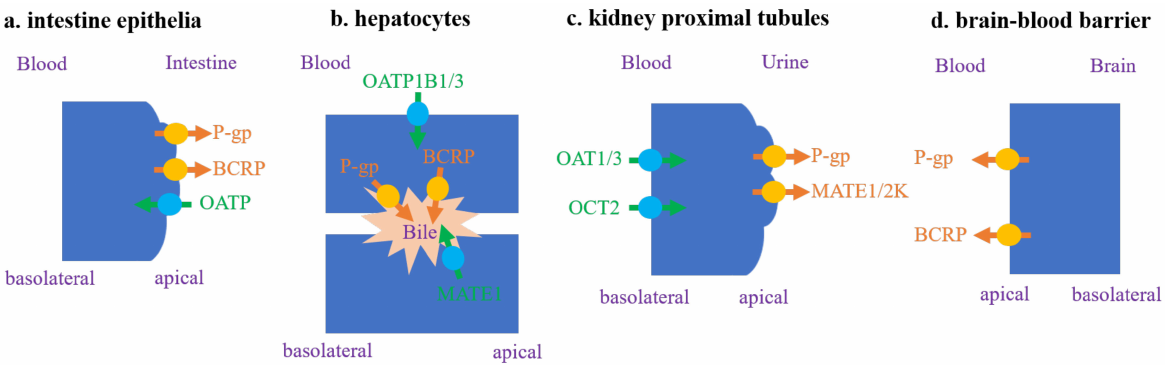
Figure 1. Transporters with a high clinical interest in drug–drug interactions (DDI) evaluation